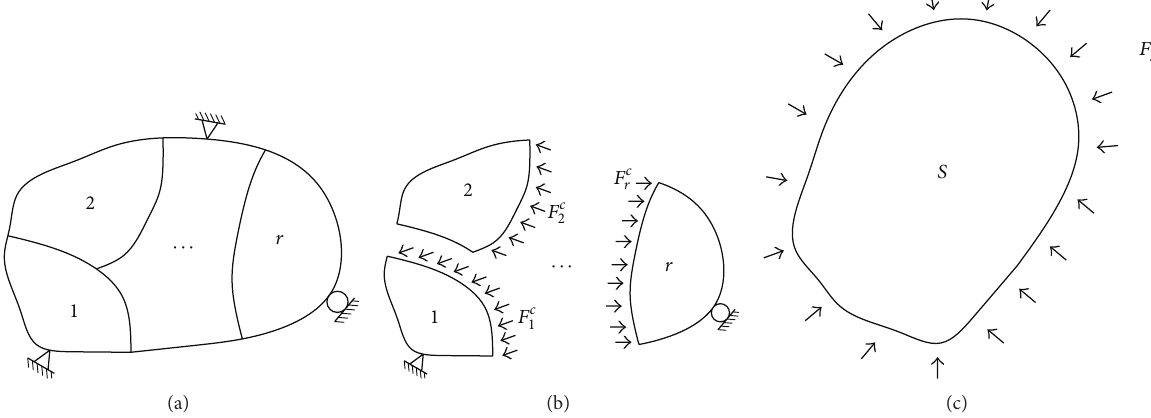
Figure 1: Substructuring of a global structure: (a) a global structure, (b) decomposition of 𝑟 substructures, and (c) 𝑠 th substructure subjected to external and constraint